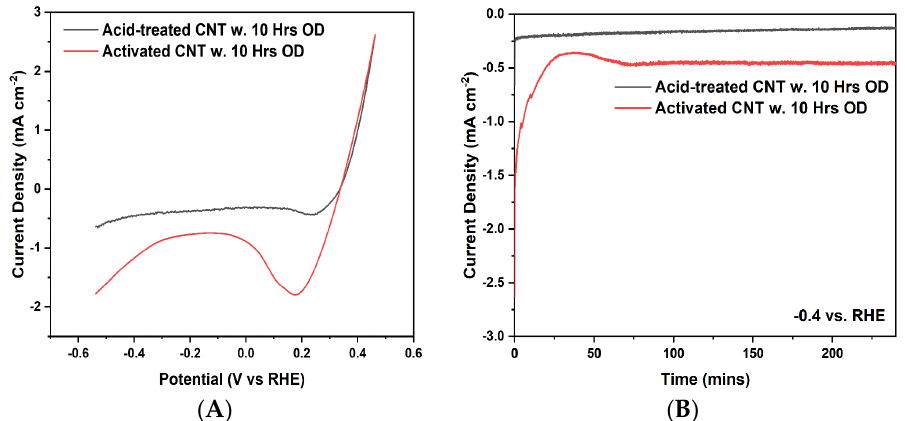
Figure 5. LSV curve ( A ) and potentiostatic curve ( B ) of acid-treated CNT with 10 Hrs Cu organic deposition and activated CNT with 10 Hrs organic deposition.